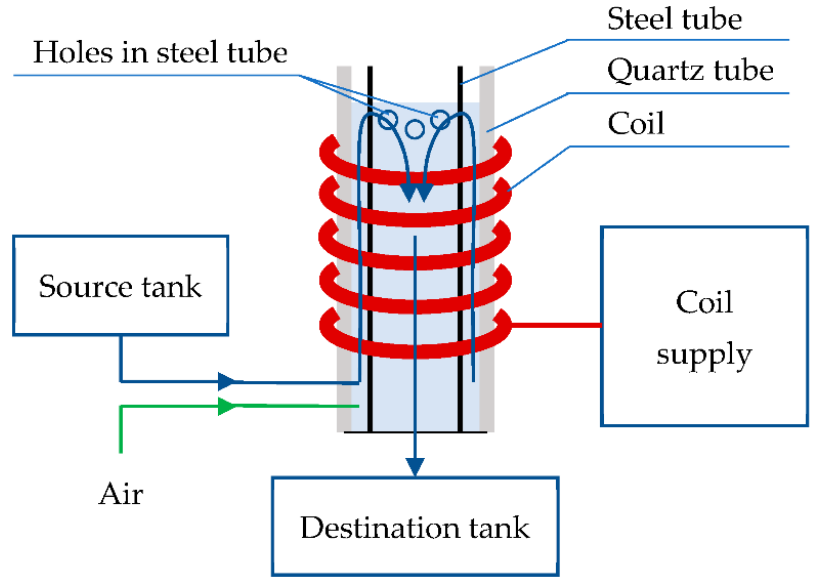
Figure 1. Schematic diagram for the nonthermal plasma reactor with dielectric barrier discharges.